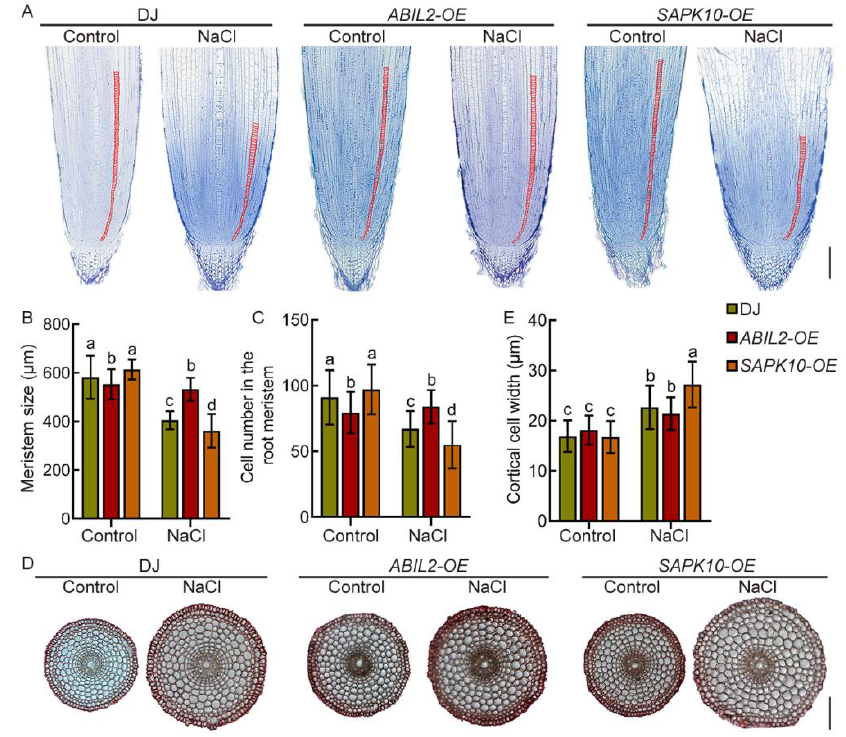
Figure 3. Salt inhibits cell proliferation and promotes cortical cell expansion in the root meristem, dependent on ABA signaling. ( A and D ) Longitudinal sections ( A ) and cross-sections ( D ) of primary root tip s (lower) of 4-day-old DJ, ABIL2-OE, and SAPK10-OE seedlings treated with 0 mM and 100 mM NaCl. Red lines delimit the meristem size (i.e., the distance between the quiescent center and the transition zone). Bar = 100 μm. ( B , C , and E ) Length of root meristematic zone ( B ), cortical cell number in the root meristem zone ( C ), and cortical cell diameter ( E ) of the corresponding seedlings indicated in ( A ) and ( D ). In ( B , C , and E ), data are means ± SD ( n ≥ 10 independent seedlings). Different letters indicate significant differences ( p < 0.05, one- way ANOVA with Tukey’s test).